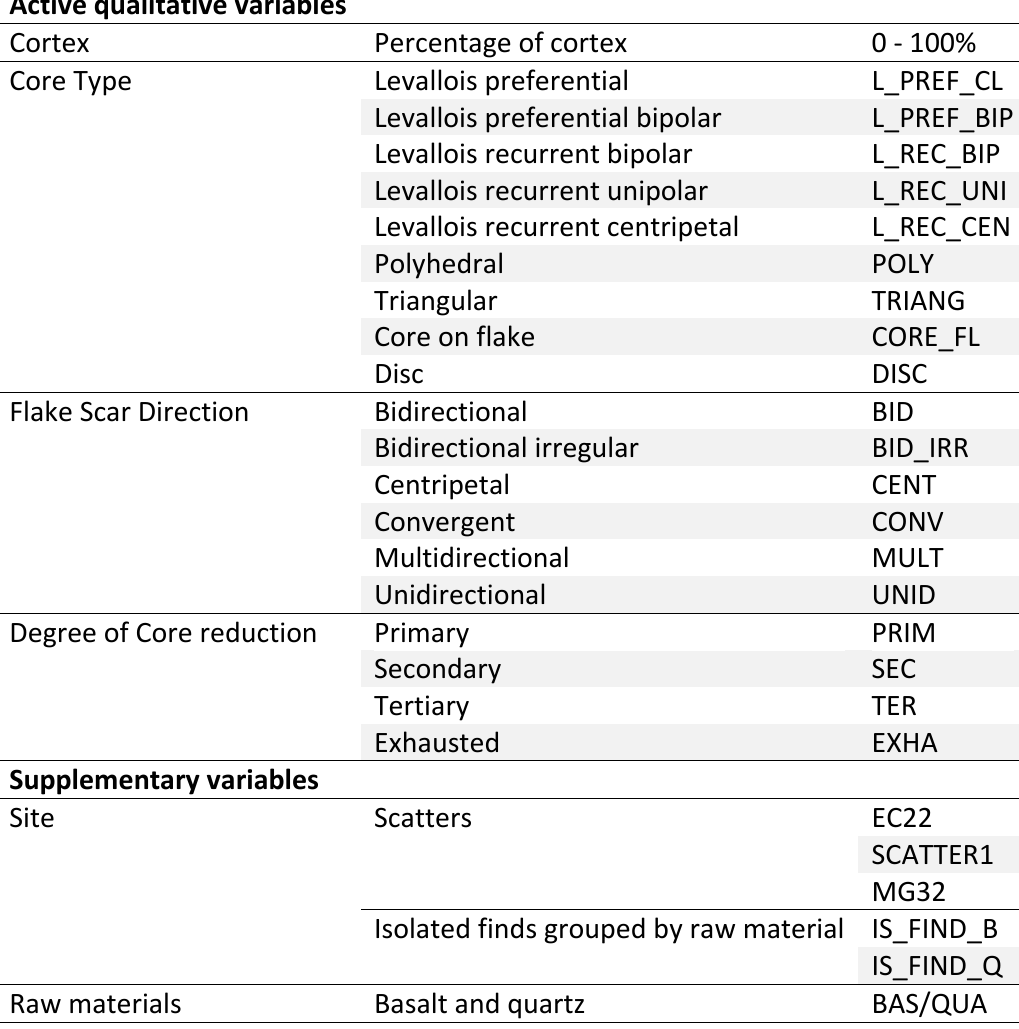
Table 5. List of categorical variables used to perform the Correspondence analysis on